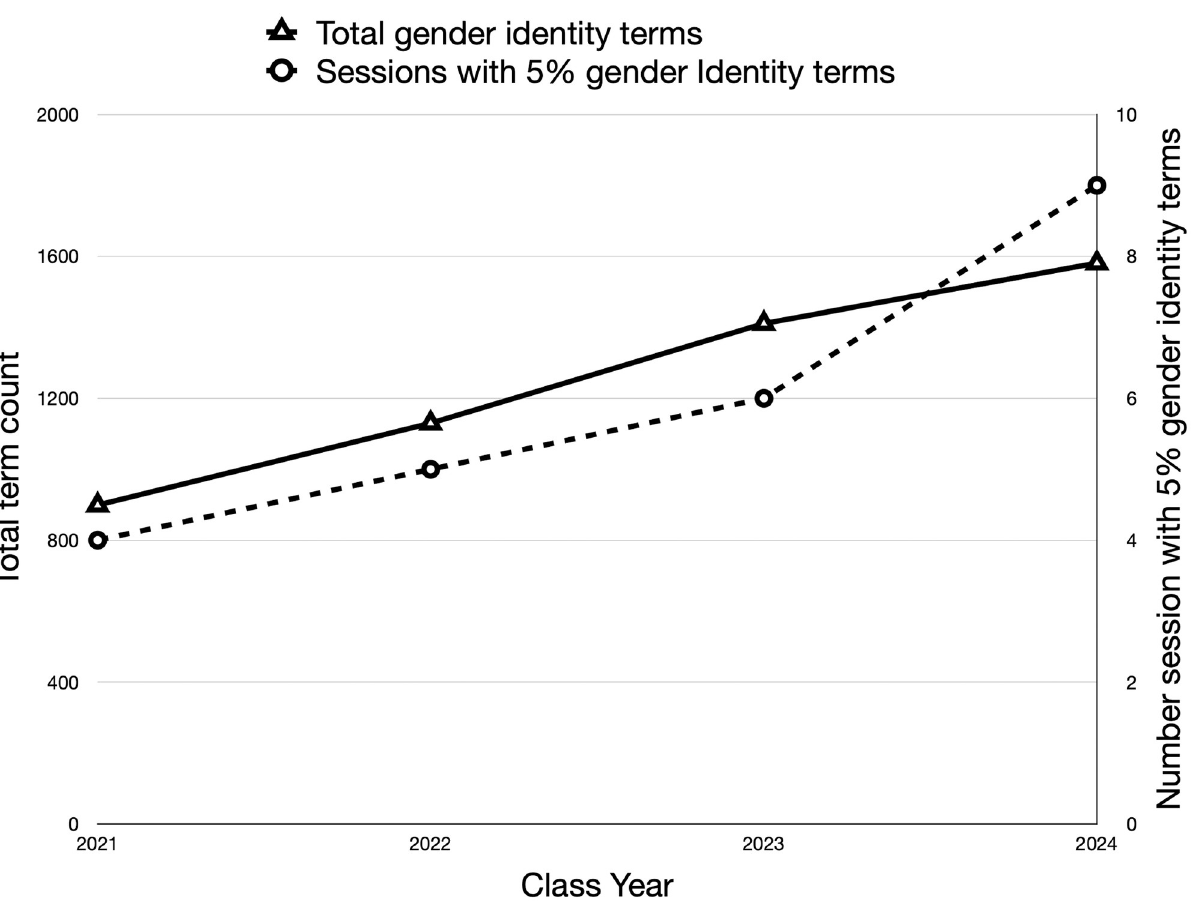
Fig 3. Change in use of gender and gender identity terms across four years of pre-clerkship curricula. The total number of gender identity terms used in four years of pre-clerkship curricula (triangles). The number of sessions in which 5% of the terms in the documents were gender identity